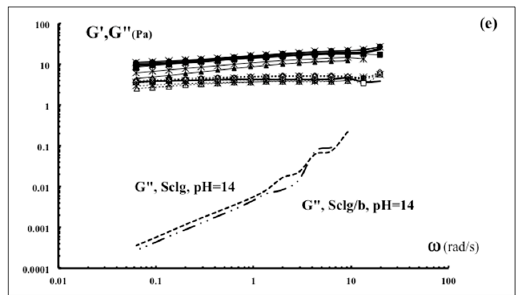
Figure 1. Flow curves of Sclg ( a ) and Sclg/borax ( b ) samples at different pH values; ( b’ ): viscosity at stress τ = 16 Pa ( η 16 ) for Sclg and Sclg/borax samples at different pH values. Mechanical spectra of Sclg ( c ) and Sclg/borax ( d ) at different pH values. In Figure ( e ), the data for both samples are reported together with the loss modulus G” values recorded at pH = 14 (polymer concentration, cp = 0.7%, T = 25 °C). In Figure ( b – e ), for an appropriate comparison, the data of Sclg are also shown.